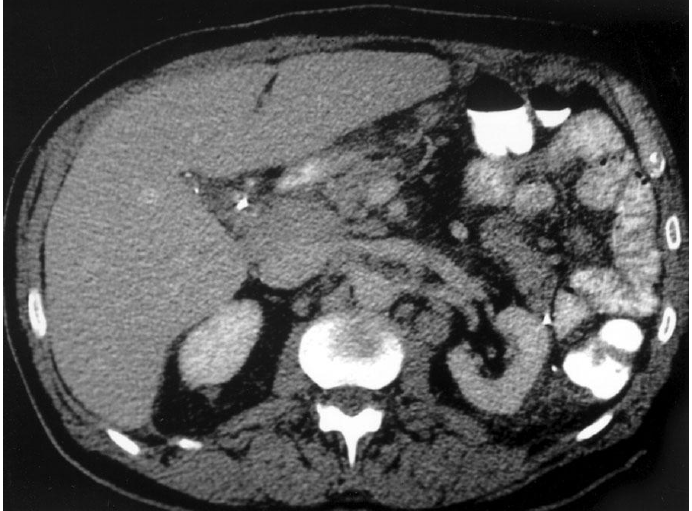
FIGURE 2. Six-month postoperative abdominal CT scan demonstrating a left kidney with normal appearance after